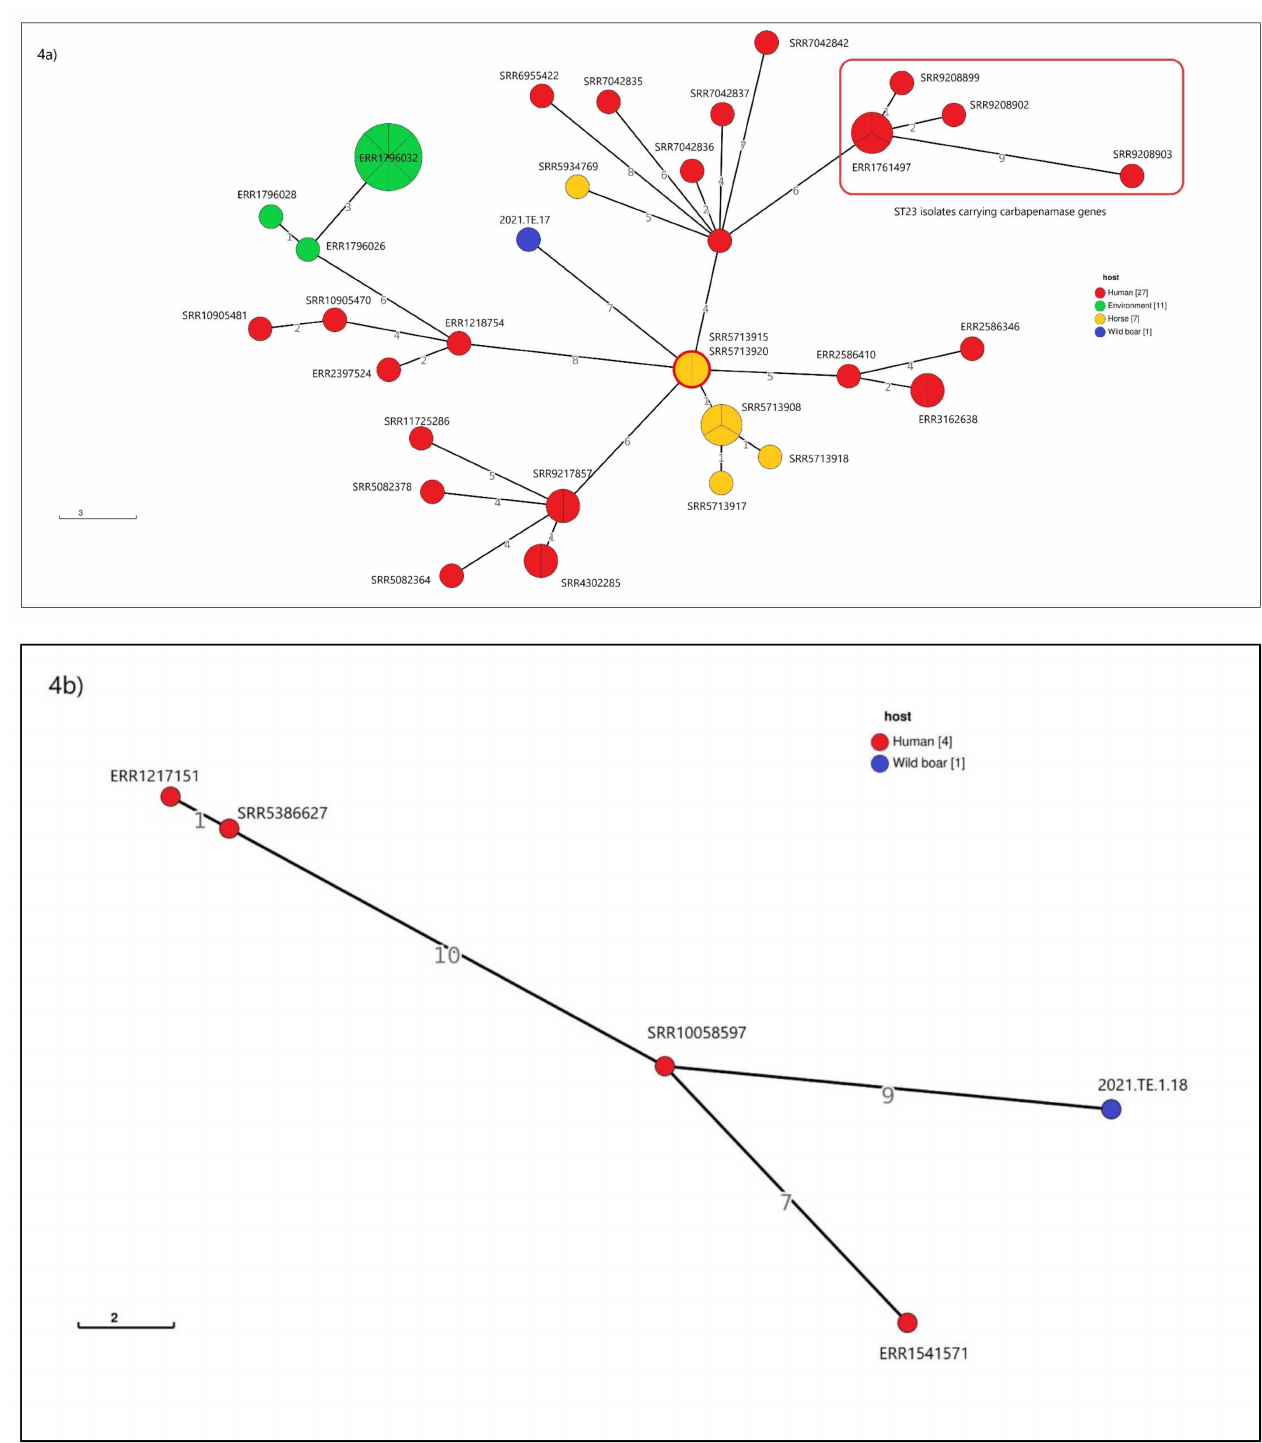
Figure 4. Cluster analysis performed with public genomes available on Pathogenwatch platform. ( a ) Core-genome MLST (cgMLST) analysis of the isolate 2021.TE.17 with 45 available clinical genomes belonging to the ST23. In the red circle are highlighted the ST23 public genomes carrying car- bapenemase resistance genes. ( b ) cgMLST analysis of isolate 2021.TE.18 with four clinical genomes (ERR1217151, SRR5386627, SRR10058597, and ERR1541571). In the branches it is reported the numbers of allelic